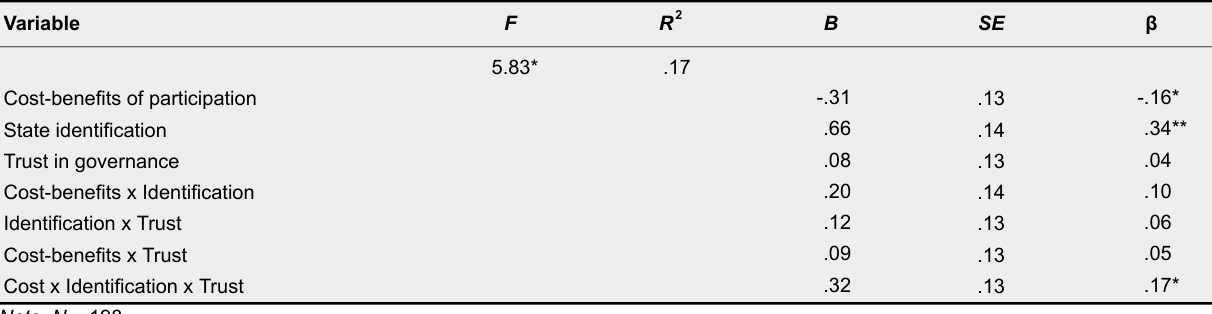
Study 2: Hierarchical Regression for Willingness to Participate in Public